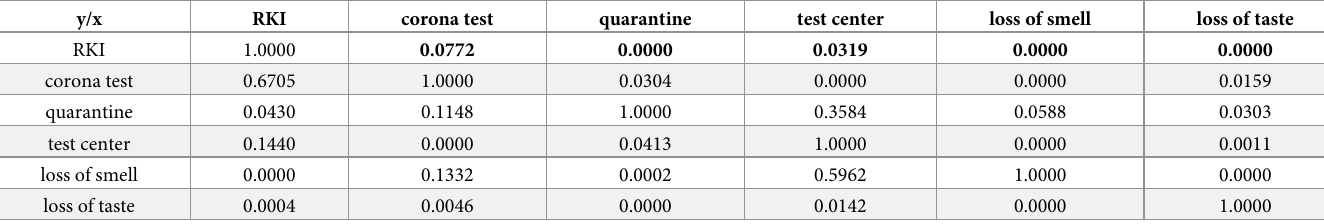
Note: Table indicates p-values from testing for Granger non-causality of column variables for row variables.